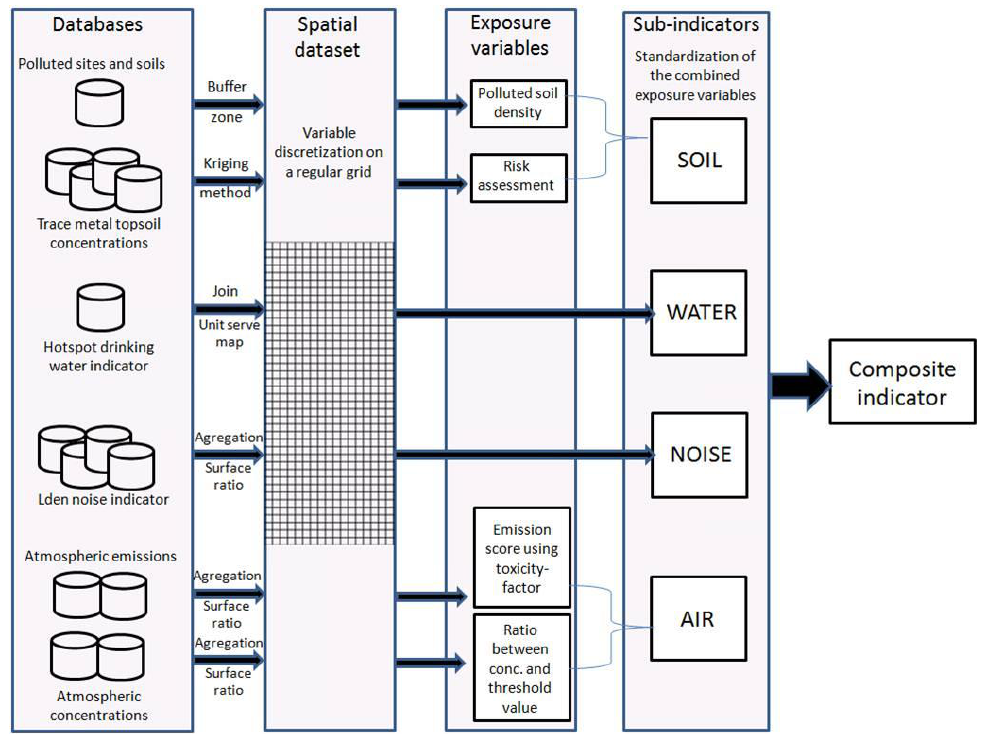
Figure 1. Conceptual framework of the data proceeding for determining composite indicators.